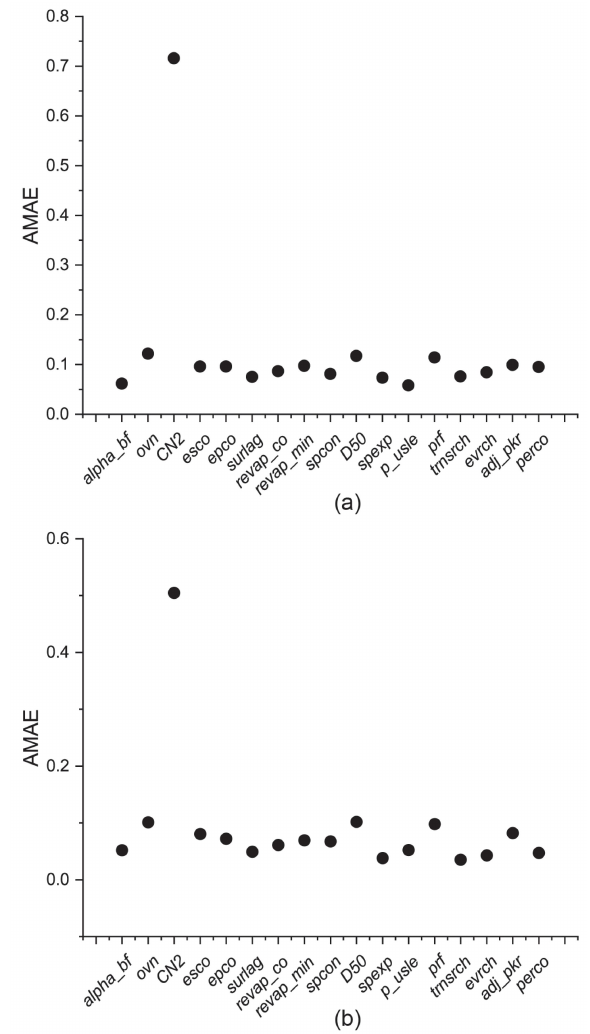
Figure 14. AMAE index for maximum daily q r ( a ) and y sed ( b ) at the outlet